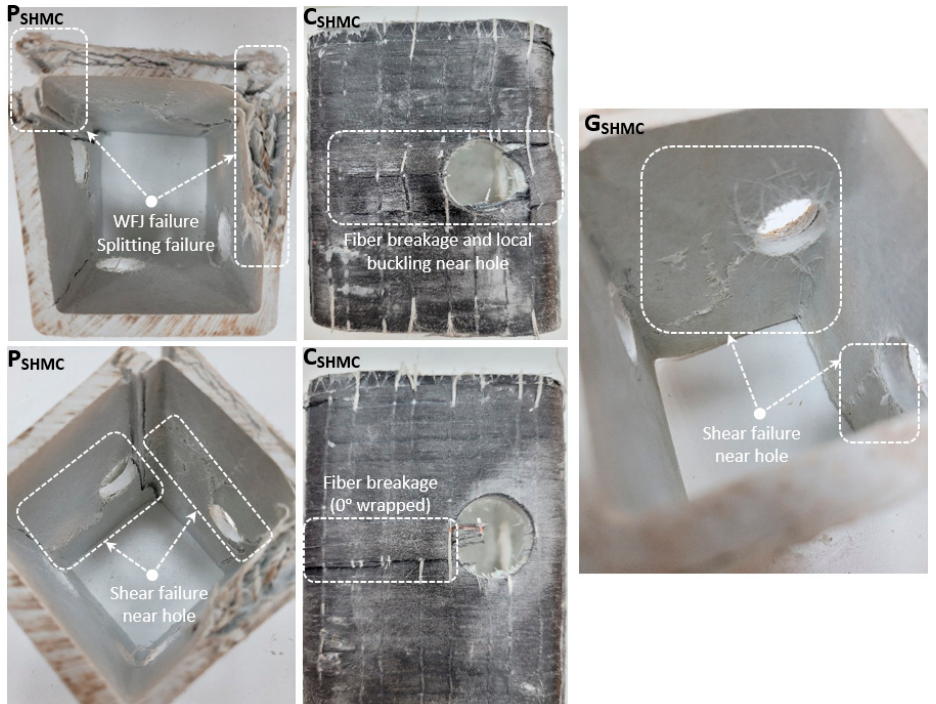
Figure 5. Damage analyses of P SHMC , C SHMC , G SHMC .